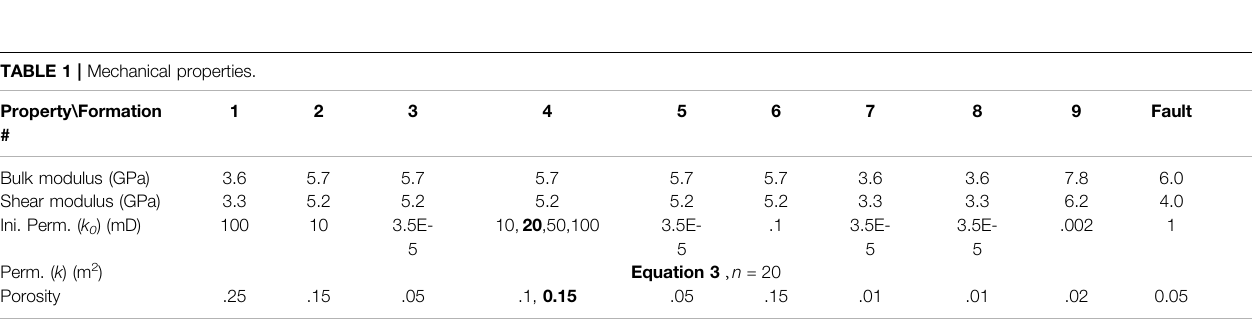
TABLE 1 | Mechanical